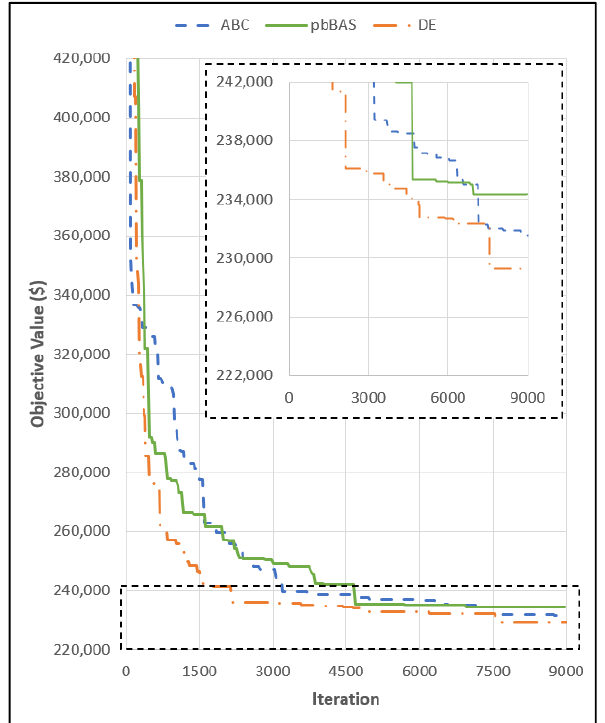
Figure 14. Design history of the worst run achieved by each metaheuristic algorithm for the V-type folded plate roof problem.